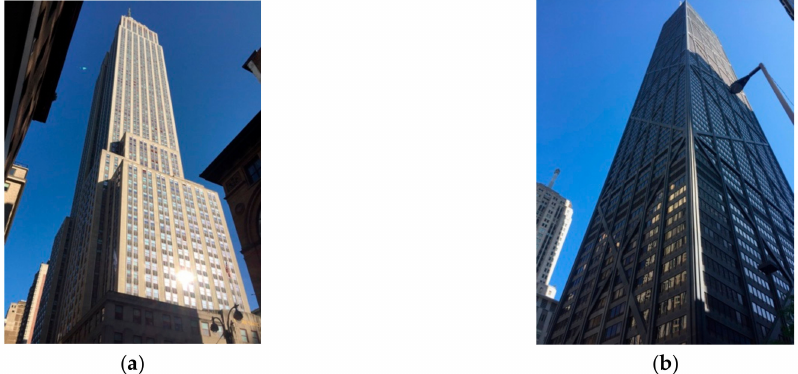
Figure 1. Di ff erent structural systems for 20th century tall buildings: ( a ) Moment resisting frame: Empire State Building (New York, NY, USA); ( b ) Braced tube: John Hancock Center (Chicago, IL, USA). Pictures taken by D.